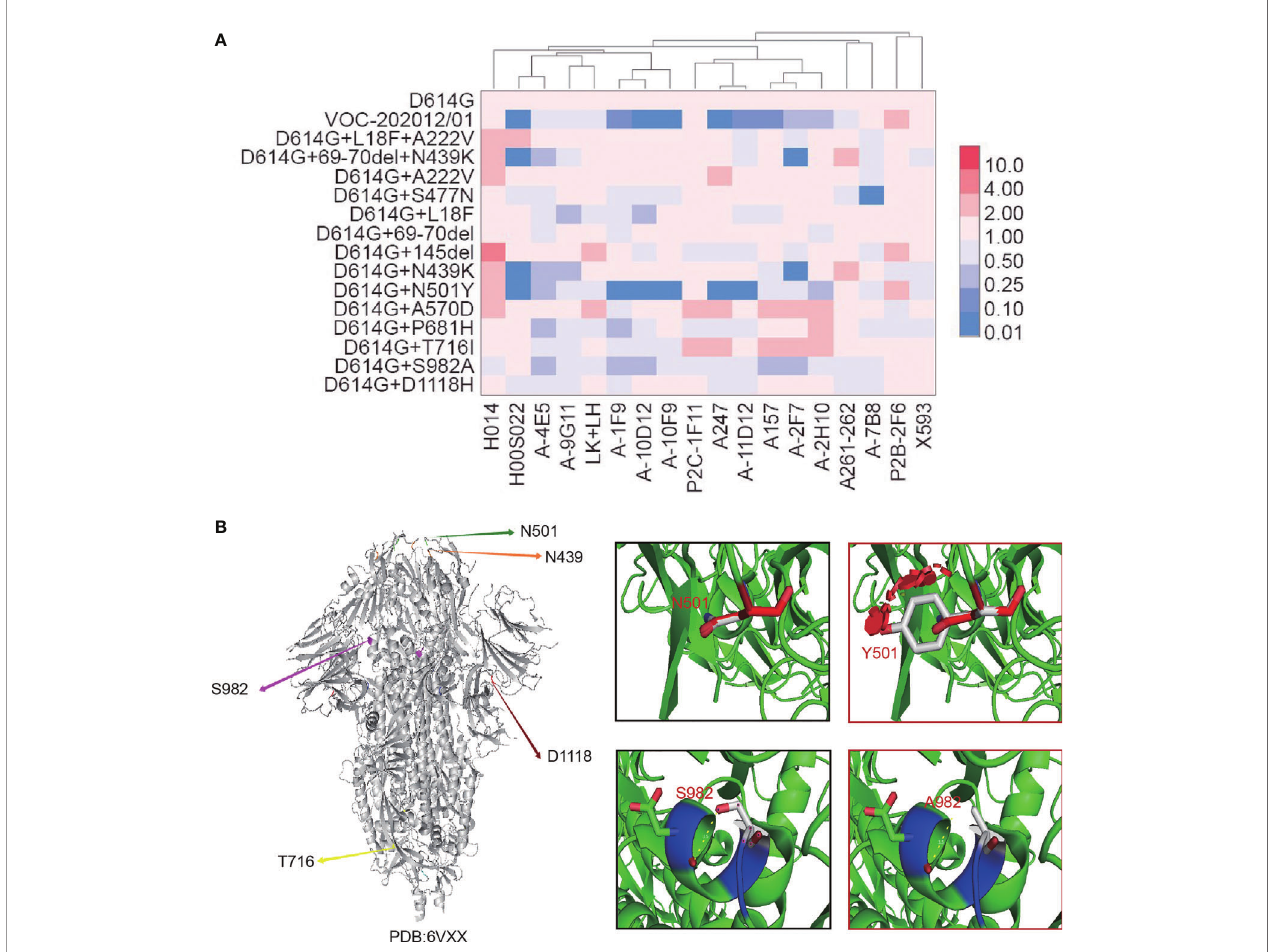
FIGURE 2 | The neutralization activity of mAbs against 16 SARS-CoV-2 variants and mutations. (A) Monoclonal antibodies were serially diluted and mixed with equal amounts of the fi ve different SARS-CoV-2 variants and those containing a single mutation. After pre-incubation at 37°C for 1 h, trypsinized Huh 7 cells were added. After cultivation for 24 h, the luminescence of the target cells was measured. The neutralization inhibition rate of the antibody and ID 50 was calculated using the Reed – Muench method. The data represent the ID 50 ratio of each variant to that of D614G. The neutralization ability of 19 different monoclonal antibodies ( x axis ) against 16 SARS-CoV-2 variants and mutations ( y axis ) are shown as heatmap. Red represents an increase in neutralization capacity, while blue represents a decrease in neutralization capacity. Four-fold changes were considered statistically signi fi cant. (B) Structure modeling of the mutation N501Y in S1 and S982A in S2 based on “ 6VXX ”